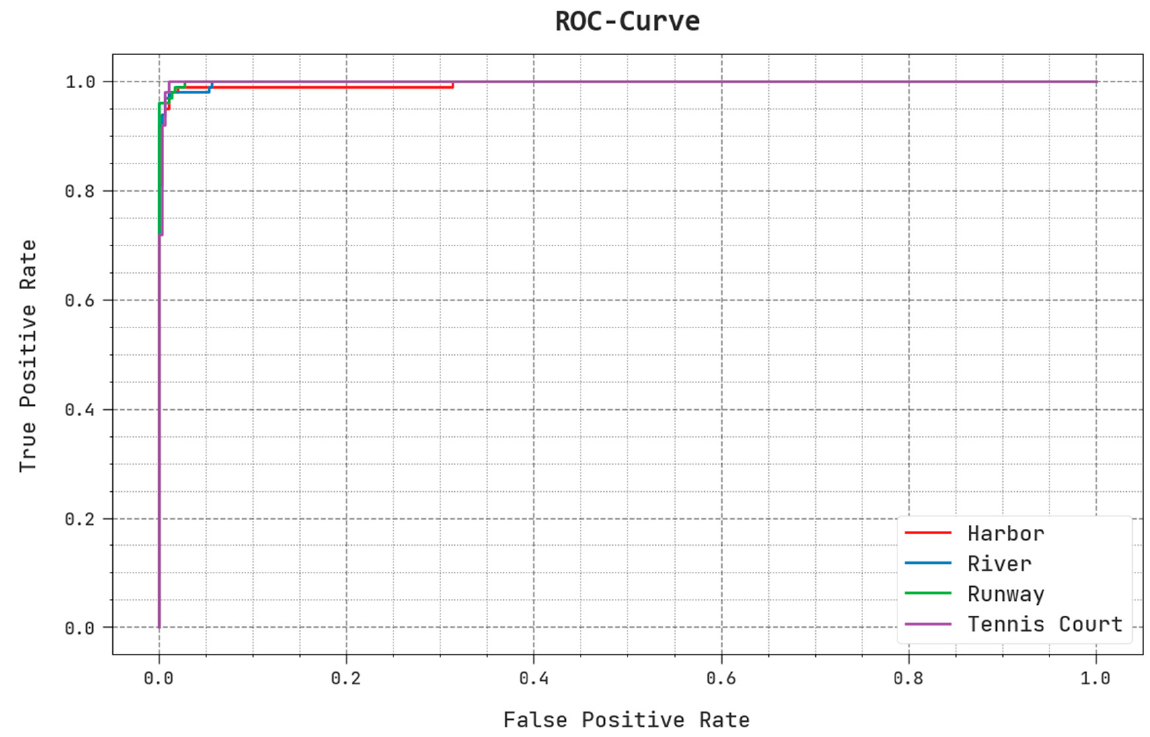
Figure 12. ROC outcomes of the BSBE-PPODLC approach.